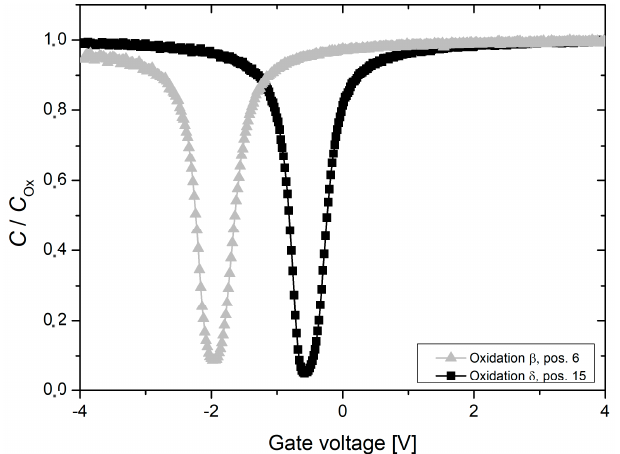
Figure 4. Effective lifetime as a function of the optical generation rate measured in the center of different wafers from the oxidation runs α , β , γ and δ , respectively.